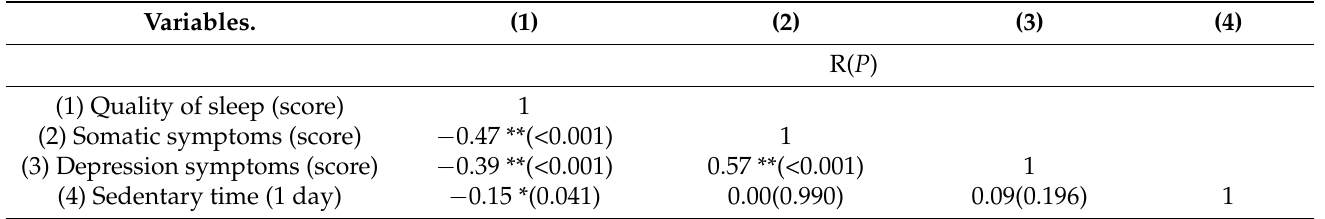
Table 3. Correlation between sleep quality and the independent variables ( N =